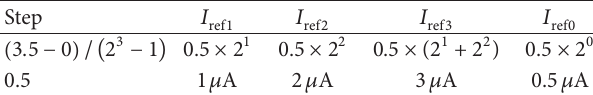
Table 2: Step and 𝐼 ref 𝑖 values for 𝐼 in = 2.5 𝜇